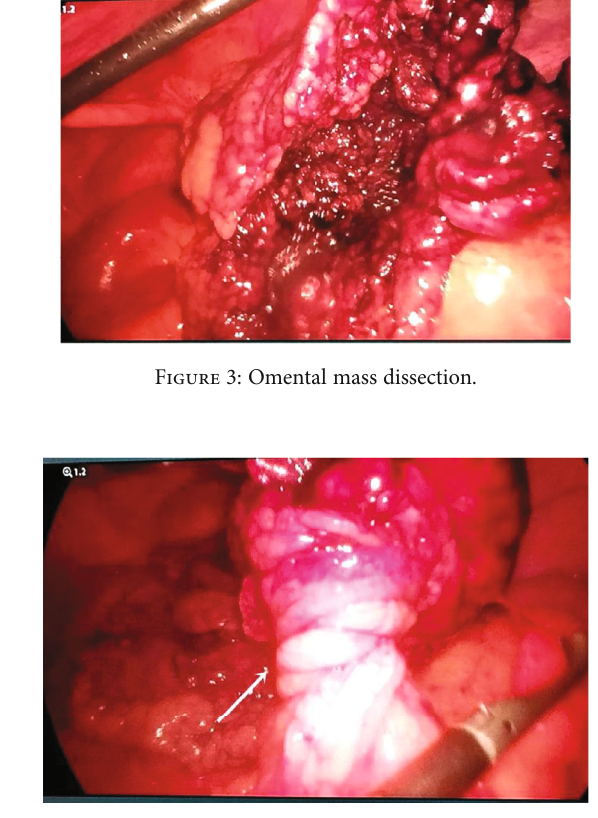
Figure 4: Omental torsion.